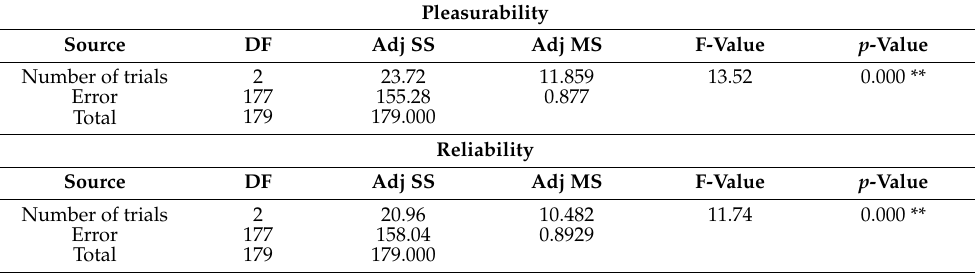
Table A2. One-way ANOVA for “Number of trials to get the right answer for a question”. **: p -value < 0.05.